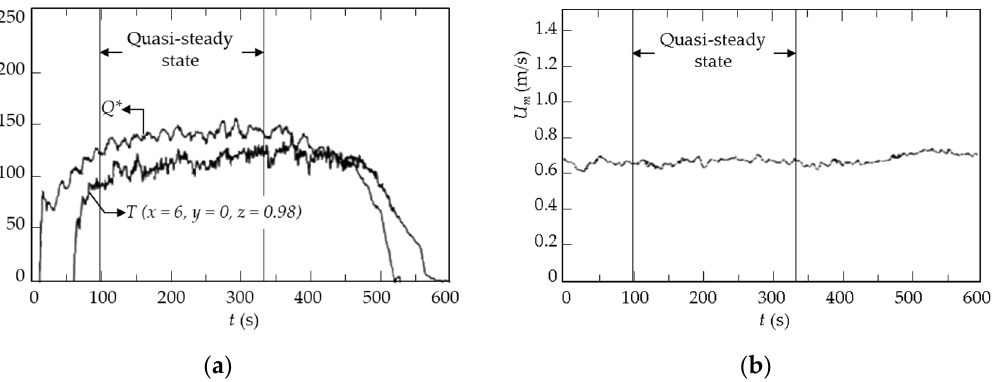
Figure 7. Initial longitudinal velocity U mi = 0.71 m/s, Q m = 153 kW ( Q m * = 0.072): (a) HRR and temperature distributions; (b) Longitudinal velocity.